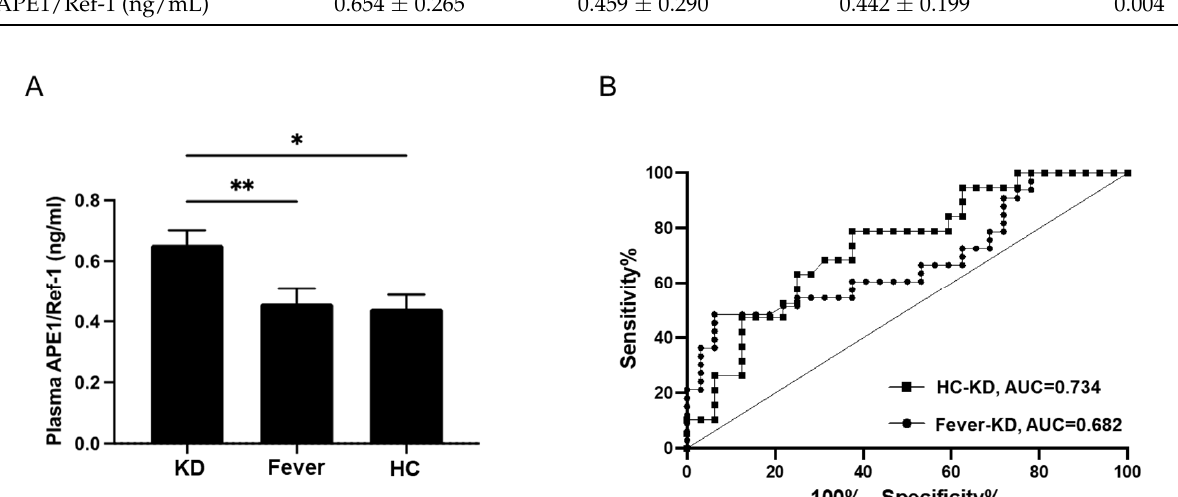
Figure 1. APE1/Ref-1 levels in the three groups, i.e., KD, fever, and healthy control groups. ( A ) APE1/Ref-1 levels were higher in the KD group than in the fever group (** p = 0.019) and the healthy control group (* p = 0.007). ( B ) The ROC curve of APE1/Ref-1 predicting KD, the cutoff value of APE1/Ref-1 predicting KD compared with that in the fever group was 0.542 ng/mL (AUC = 0.682; sensitivity of 60.6%; specificity of 62.5%), and the cutoff value of APE1/Ref-1 predicting KD compared with that in the healthy group was 0.482 ng/mL (AUC = 0.734; sensitivity of 68.4%; specificity of 68.7%), KD, Kawasaki disease; HC, healthy